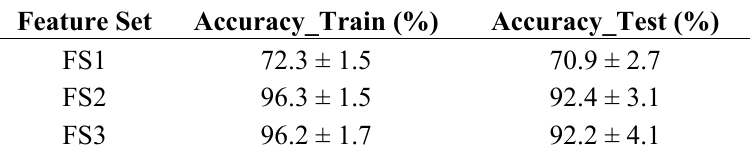
Table 6. System performance of the three-class classification using different feature